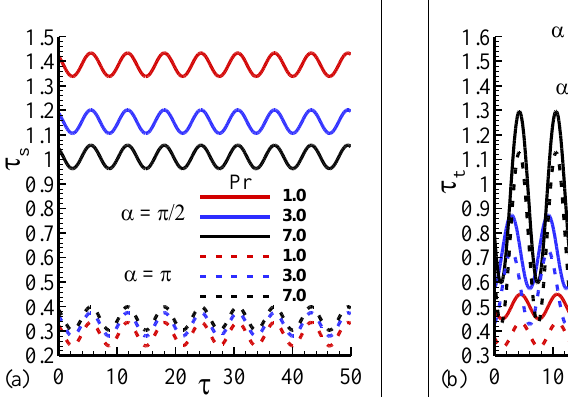
Figure 6. The geometrical plots of ( a ) 𝜏 𝑠 ( b ) 𝜏 𝑡 , and ( c ) 𝜏 𝑚 at 𝜋 2⁄ and 𝜋 positions with two values of Pr = 1.0,3.0 and 7.0 with some fixed parameters 𝜉 = 0.3 , Rg = 0.1 , 𝛾 = 0.1 , and 𝜆 = 1.2 .